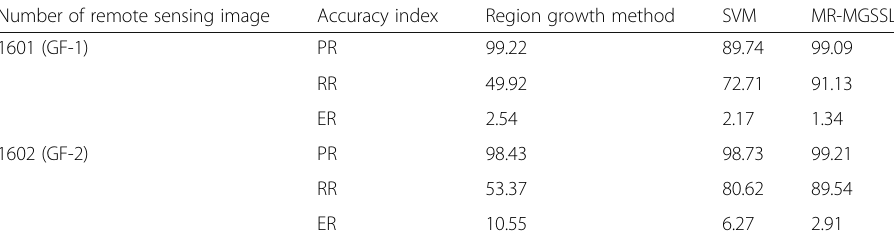
Table 2 Comparison of accuracy indicators of different cloud detection algorithms